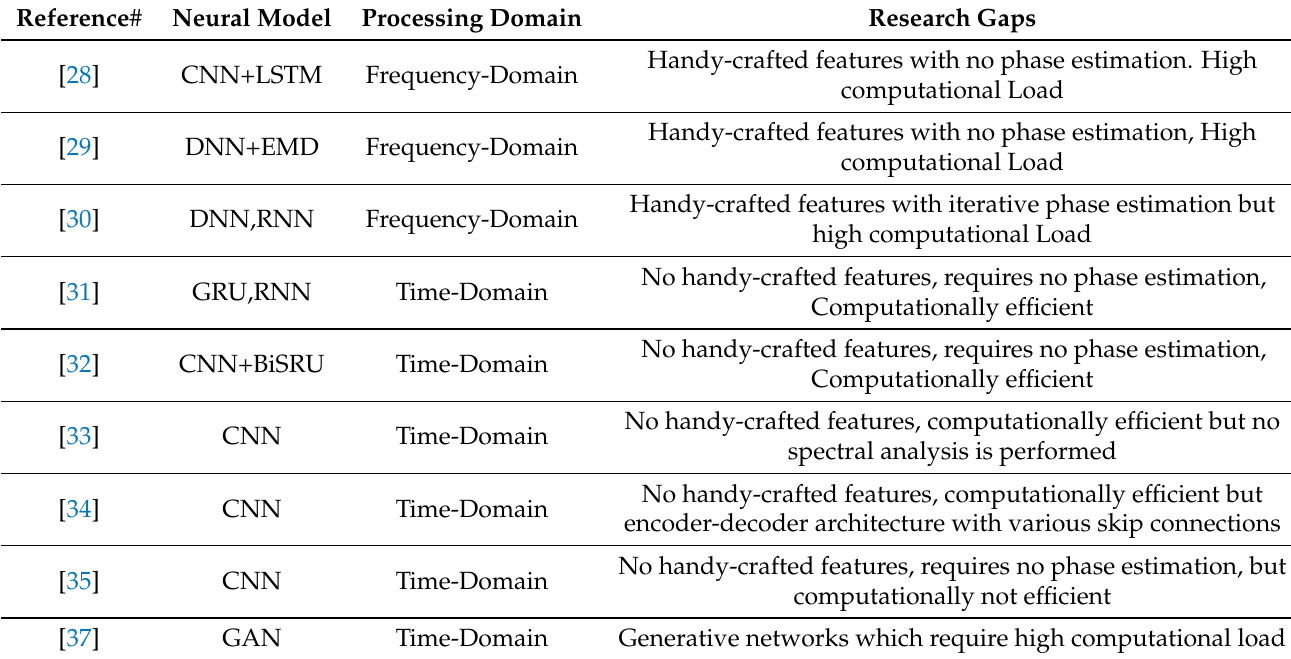
Table 1. Summary of Related